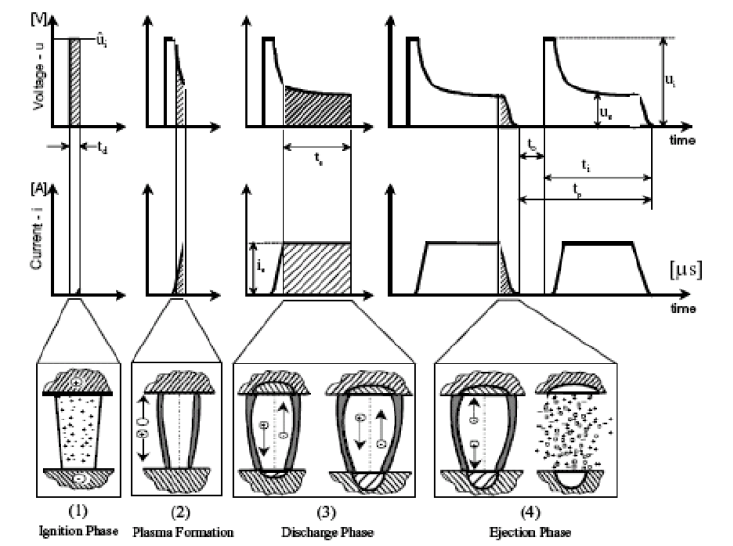
Figure 1. EDM phases